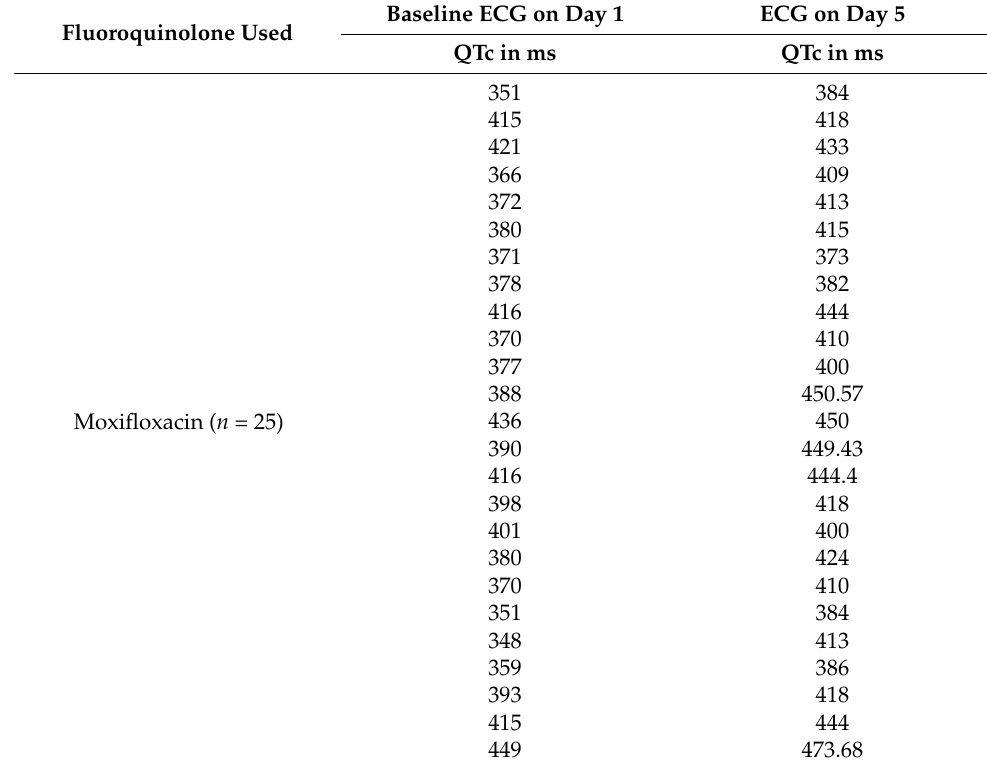
Table 3. QTc interval measured in milliseconds in twenty-five participants treated with Moxifloxacin.